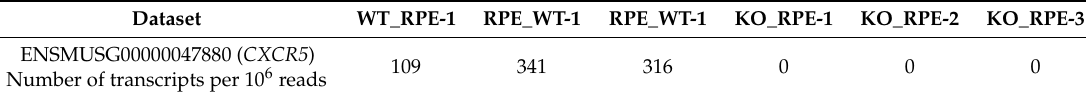
Table 3. Number of CXCR5 transcripts in WT and CXCR5 KO